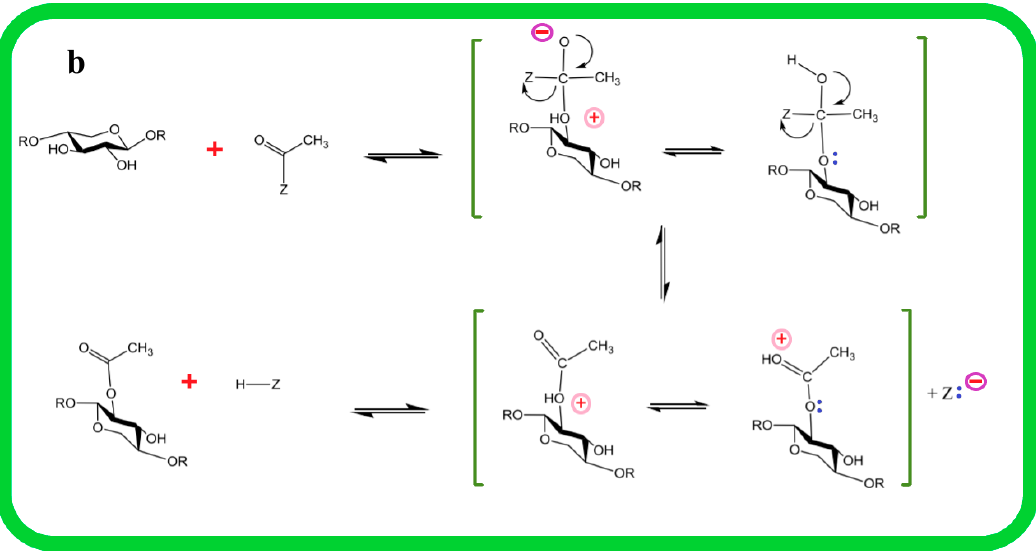
Figure 2. Mechanism of xylan biosynthesis and acetylation: ( a ) sucrose synthesized from photosynthesis is major source for UDP-glucose (UDP-G), which serves as a substrate for synthesis of various intermediates involved in xylan side chain or backbone synthesis. The Golgi is the actual site for xylan synthesis, so all substrates are transported to the Golgi via different membrane transporters. Acetyl CoA, a donor of acetyl group for xylan acetylation, is synthesized in different cell compartments i.e., microbodies, mitochondria, and plastids as well as in the cytosol from where it is transported to Golgi via Reduced Wall Acetylation ( RWA ) proteins and later incorporated to xylan. ( b ) Molecular mechanism of xylan acetylation adapted from [64,65]: attachment of acetyl to xylan involves nucleophilic attack of xylan OH group lone pair electrons on carbon atoms of the acetyl group to yield acetylated xylan. Abbreviations of all enzymes and intermediates are mentioned in Abbreviation section of manuscript.